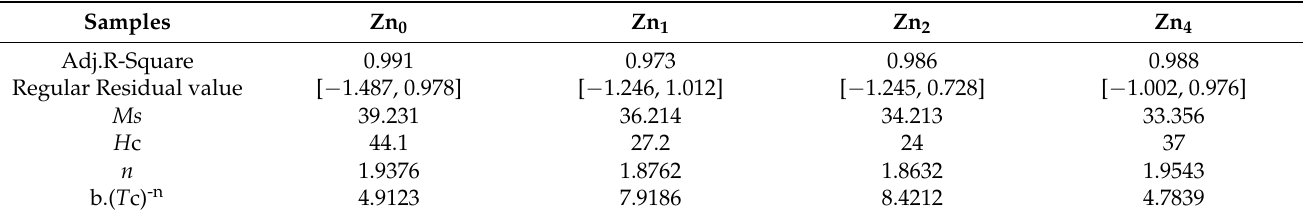
Table 1. Fitting results of saturation magnetization using the Bloch law.